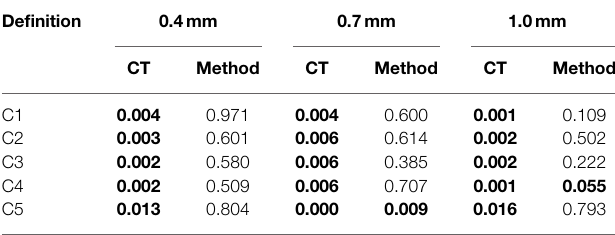
TABLE9 | The p -valuesofanalysis-of-variancetestforglasseswithdifferent thicknesses . Definition